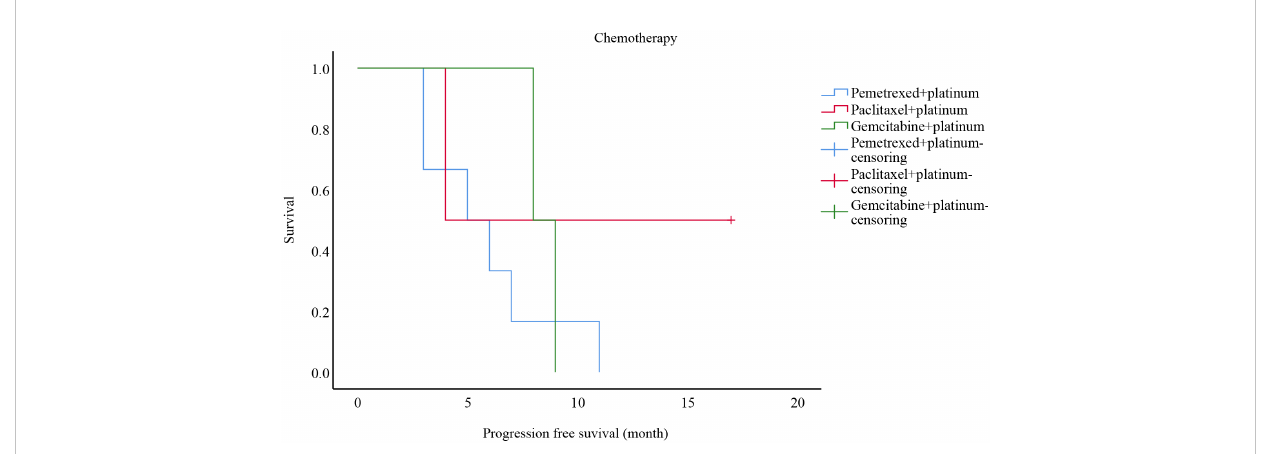
FIGURE 2 Progression free survival analysis of patients with different chemotherapy modalities in stages III-IV from